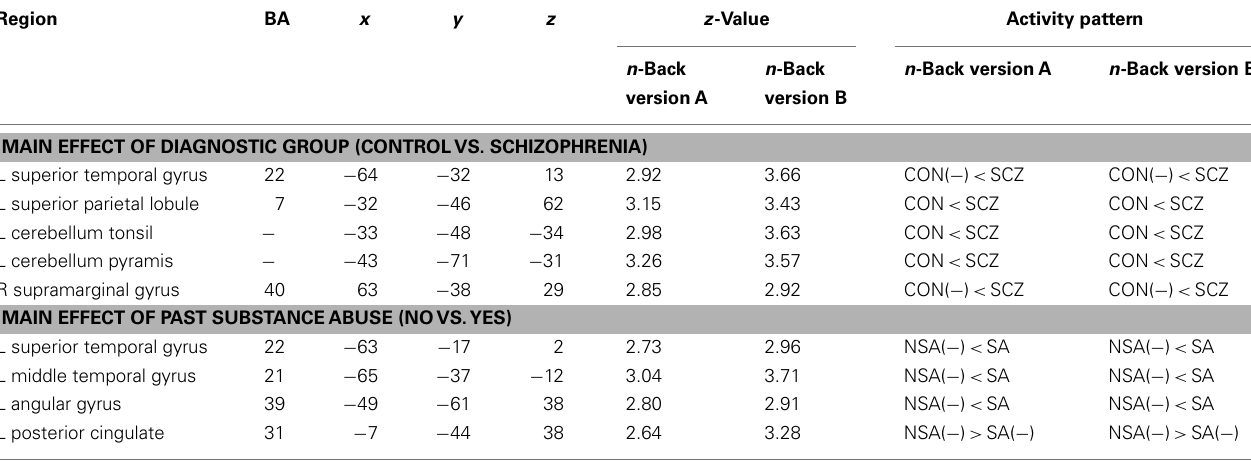
Activity patterns are activations, except when denoted with ( − ), indicating deactivation. Coordinates (x, y, z) reflect Talairach template space (57). BA, Brodmann area; L, left; R, right; CON, all control participants; SCZ, all schizophrenia patients; NSA, all participants without past substance abuse; SA, all participants with past substance abuse.